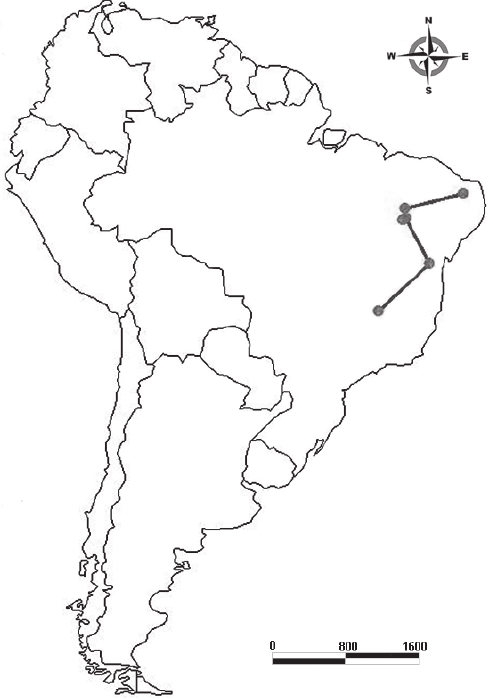
Fig. 10 - Individual track of Hoplophorus